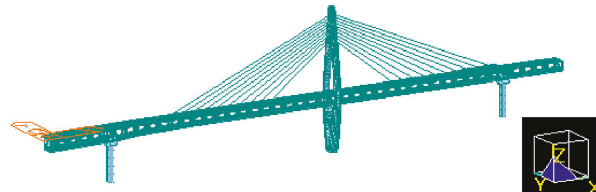
Figure 2: Finite element model of the